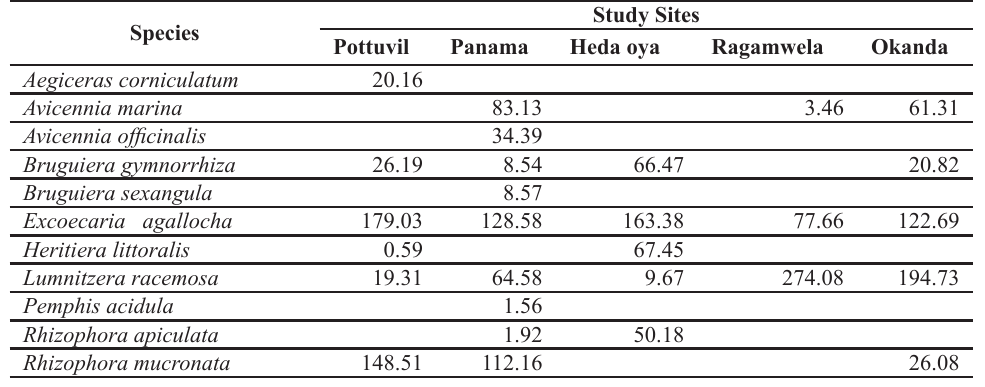
Table 5: Importance Value Index of mangrove species observed in each study cite.